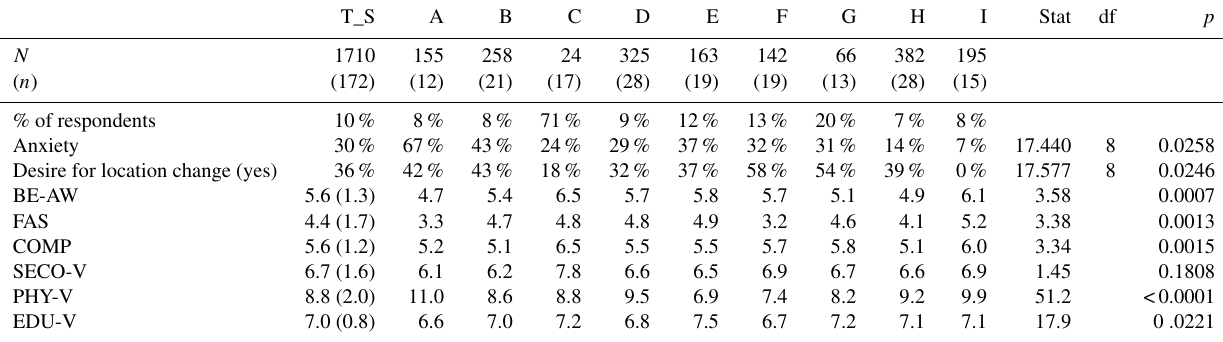
Table 5. Results with significant analyzed variable differences by neighborhood. Indications are as follows: T_S (total sample), Stat (statistic), df (degrees of freedom), p ( p value), FAS (fascination) BE-AW (being away), COMP (compatibility), PHY-V (physical vulnerability), SECO-V (socioeconomic vulnerability) and EDU-V (educative vulnerability). Standard deviation in